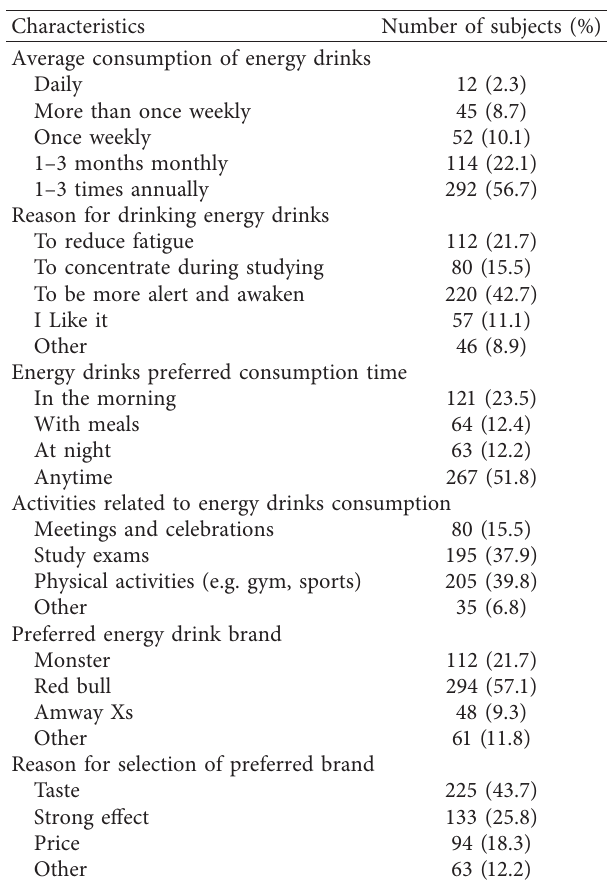
Table 3: The consumption pattern of participants towards energy drinks.